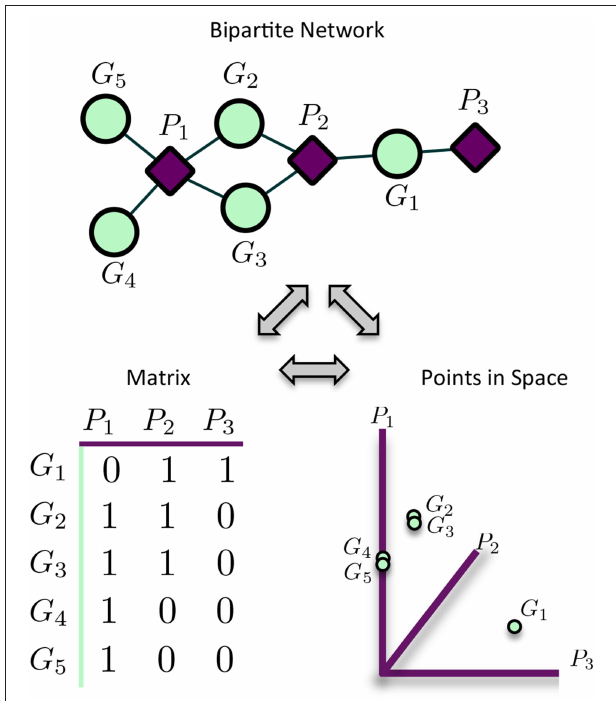
FIGURE 4 | Representation of matrices as spaces and bipartite networks. Matrices of GWAS results can easily be represented as points in high dimensional space, with rows representing points and columns representing variables/axes. Equivalently, matrices can be represented as bipartite networks, connecting row objects (genes) with column variables if the corresponding entry is non-zero. This provides a useful way to visualize high dimensional spaces as bipartite networks.